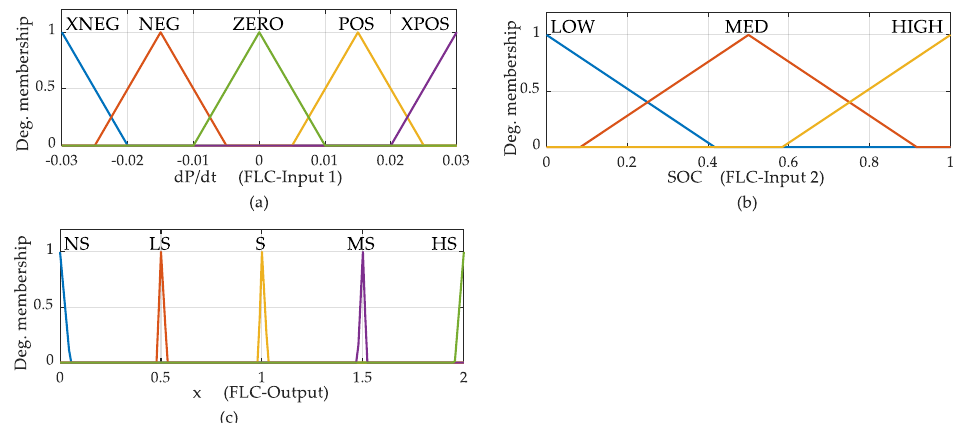
Figure 7. Membership functions of the FLC proposed: ( a ) input 1: dP WT / dt , ( b ) input 2: SOC and ( c ) output: smoothing factor x. NS = no smoothing, LS = little smoothing, S = smoothing, MS = moderate smoothing, HS = high smoothing. Values of input 1: XNEG = extra negative, NEG = negative ZERO = zero POS = positive, XPOS = extra positive. Values of input 2: low= 0%, med= 50%, high=100%. Table 1. Fuzzy rules.